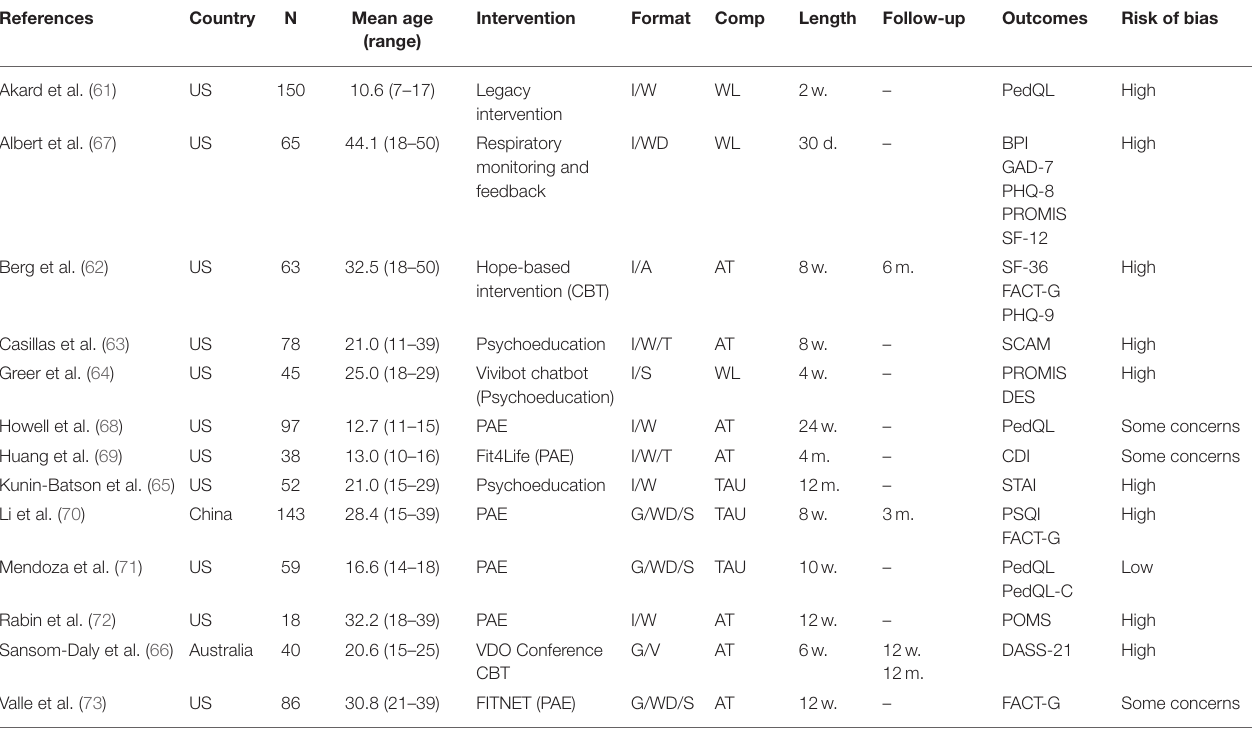
TABLE 1 | Characteristics of online interventions for pediatric, adolescent, and young adult cancer